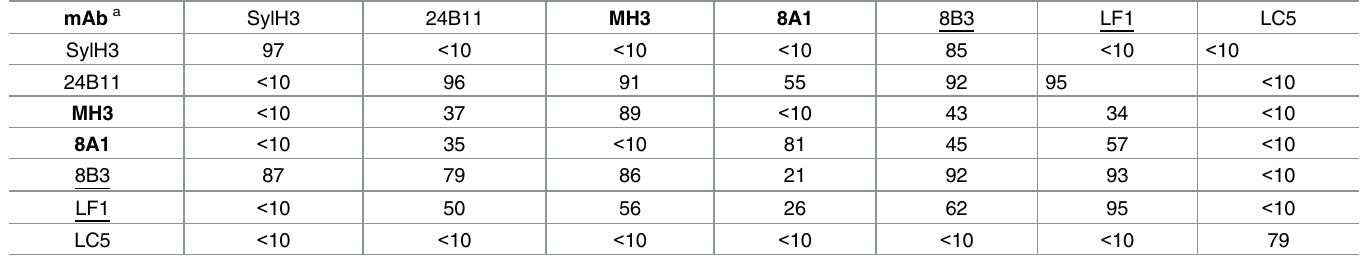
Table 2. Epitope localization by mAb competitive binding